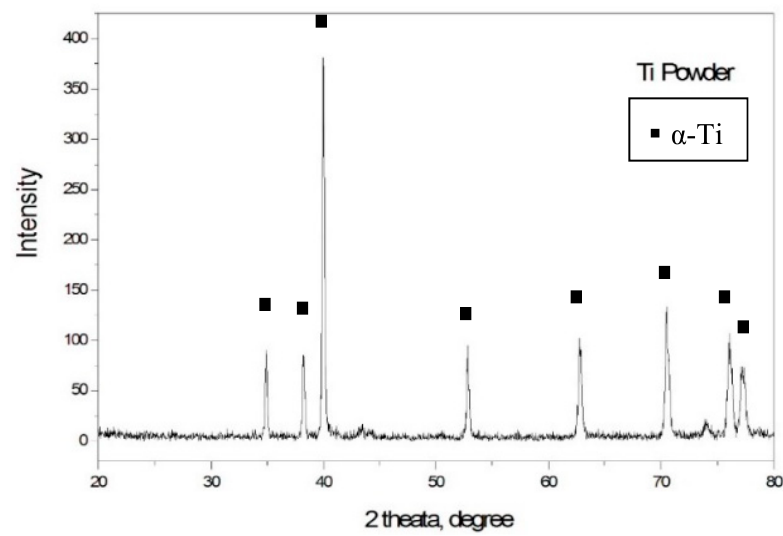
Figure 4. XRD pattern of the HDH titanium powders in the range 2 θ = 20 ◦ –80 ◦